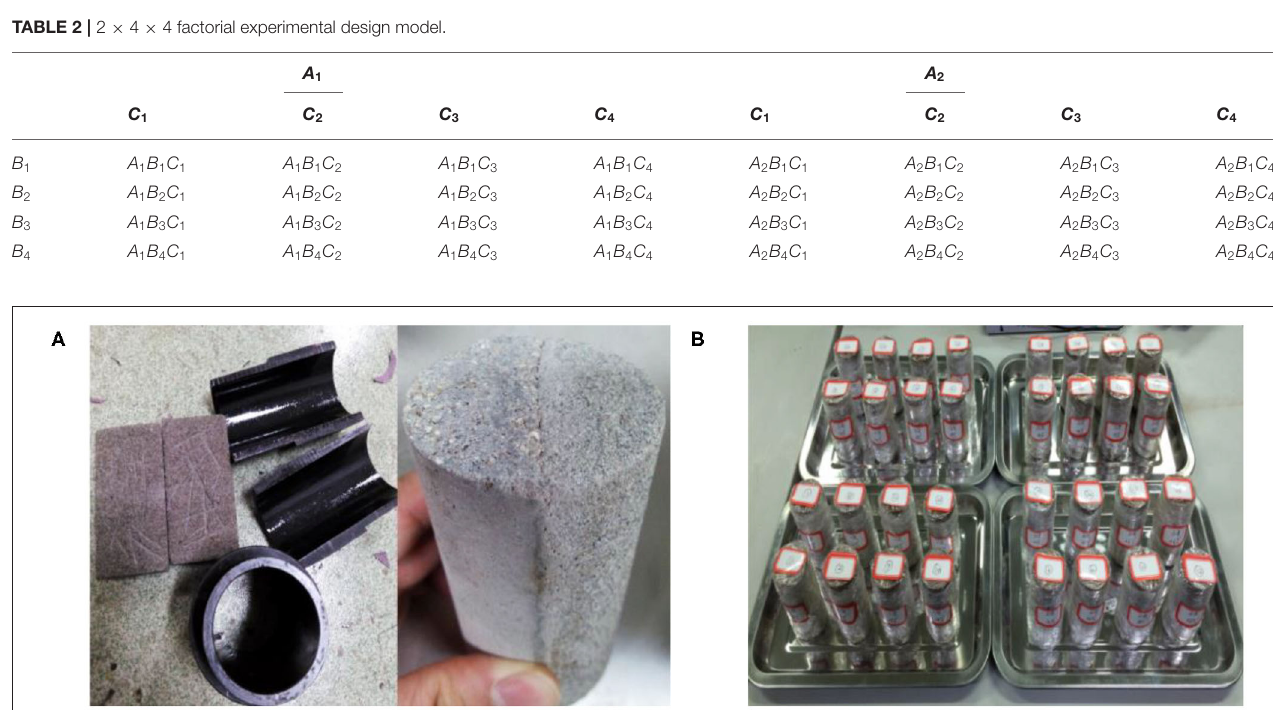
FIGURE 2 | Sandstone–concrete samples used in the experiments. (A) Combination test piece and mold; (B) compression test assembly test